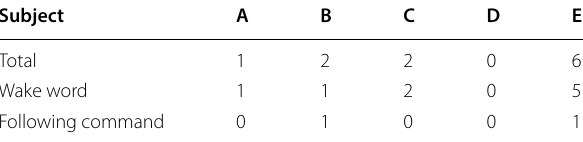
Table 3 Number of failures in ten trials